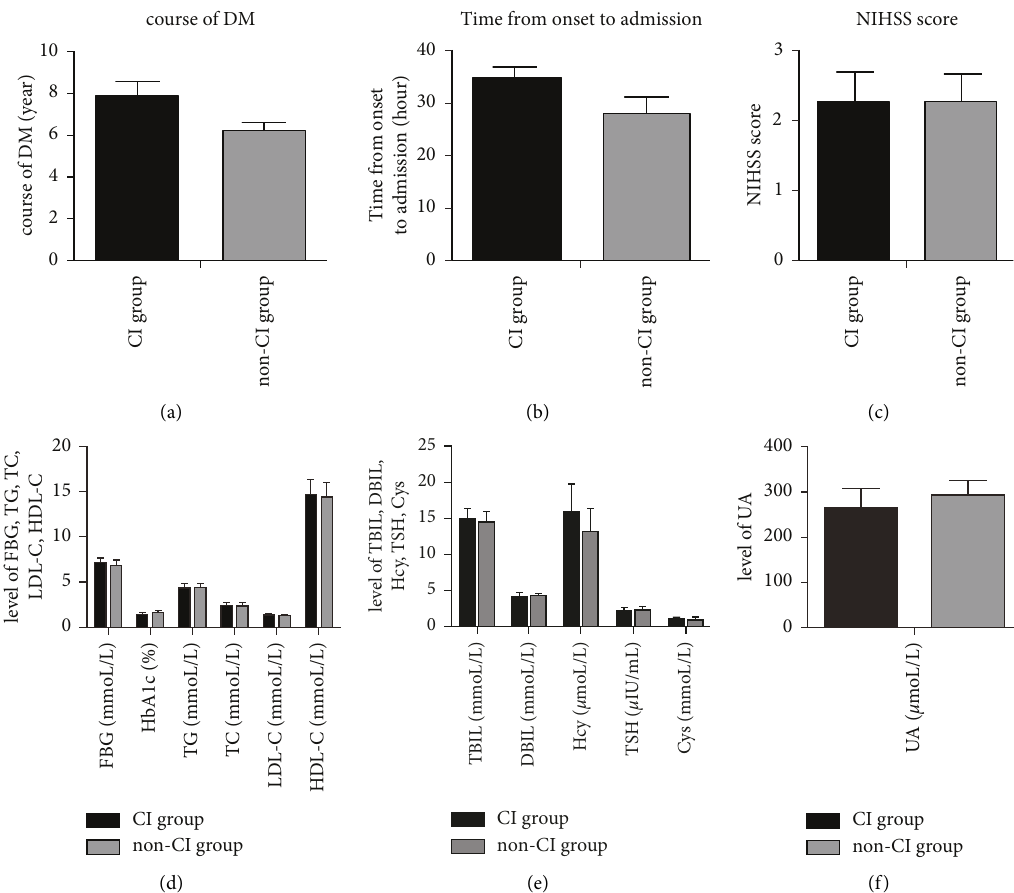
Figure 2: Comparison of measurement data between the CI group and the non-CI group: (a) course of DM; (b) time from onset to admission; (c) NIHSS score; (d) FBG, HbA1c, TG, TC, LDL-C, and HDL-C levels; and (e) TBIL, DBIL, Hcy, TSH, and Cys levels; (f): UA level. Table 1: Univariate analysis on the influencing factors of cognitive function in patients with DM complicated with AS [n(%)].